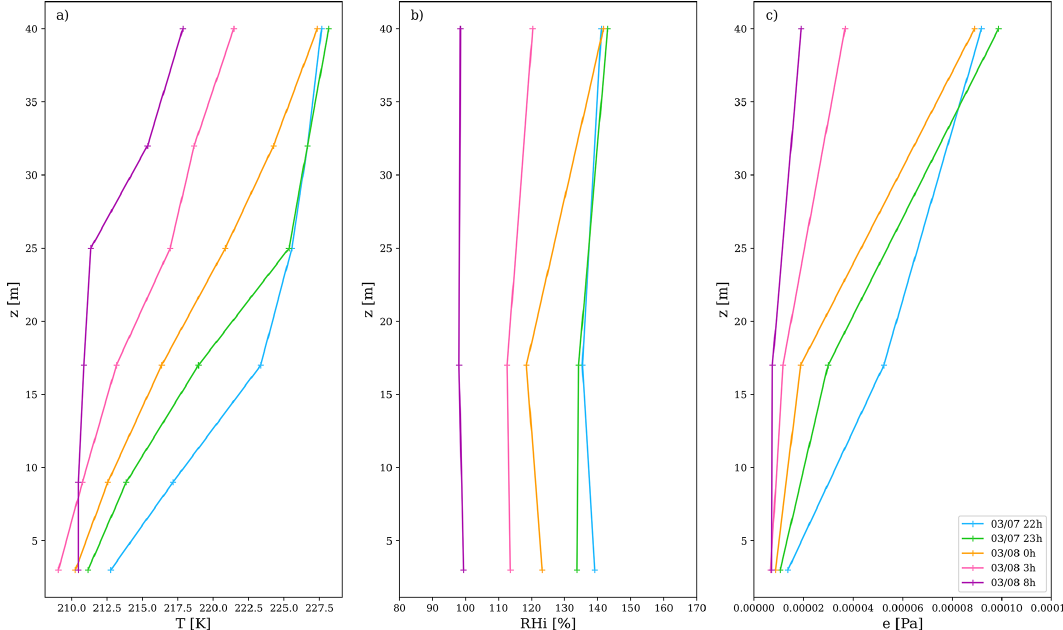
Figure 5. Vertical profiles of temperature (a) , relative humidity with respect to ice (b) and vapour partial pressure (c) at different times during the fog development